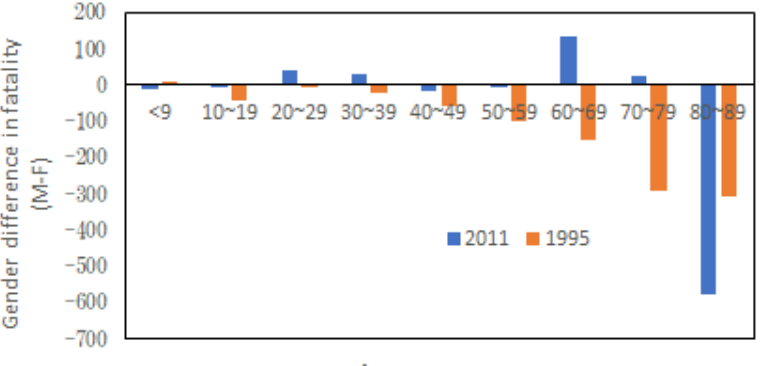
Figure 1. Gender gap in victims (men-women) in different age groups during the Hanshin-Awaji Great Earthquake and the Great East Japan Earthquake (Data source: e-Stat, Japan).